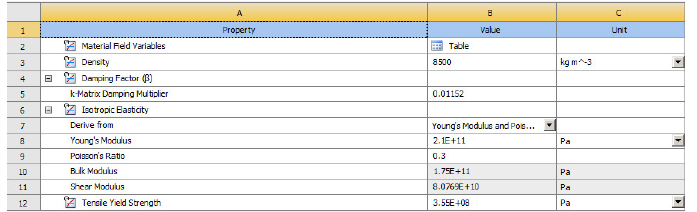
Figure 22. Transient Structural (the parameters setting).